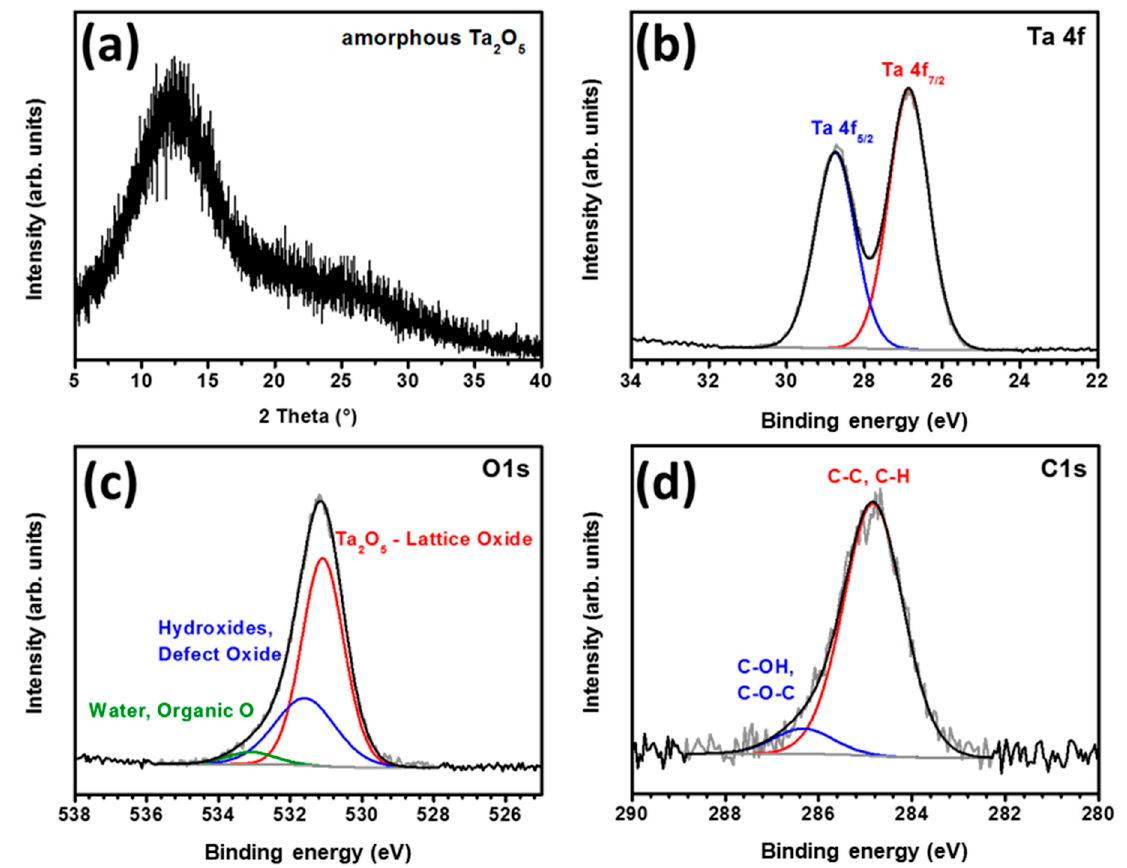
Figure 2. ( a ) XRD pattern of tantalum oxide film deposited on glass; XPS spectra of tantalum oxide showing high-resolution peaks corresponding to ( b ) Ta 4f, ( c ) O 1s and ( d ) C 1s. The electronic states and compositions of the tantalum oxide films were determined using X-ray photoelectron spectroscopy (XPS). The XPS survey spectrum is shown in Figure S4. As seen in Figure 2b, two peaks observed at 28.7 and 26.8 eV were assignable to 4f 5/2 and 4f 7/2 , respectively, corresponding to the Ta +5 oxidation state, which confirmed the formation of stoichiometric Ta 2 O 5 after annealing of the film, since the Ta +5 component was the only phase detected in Ta 4f region [49]. The O 1s region (Figure 2c) exhibited the main peak at 531.1 eV attributed to the lattice oxide, confirming the presence of an O 2 − state in Ta 2 O 5 . The higher binding energy peak centered in the region 531.6–533.1 eV can be assigned to chemisorbed oxygen, defect oxygen atoms or hydroxyl groups and possibly to surface-adsorbed water molecules or organic oxygen (residual ethoxide groups) [49]. The peaks in the C1s spectrum at 284.8 and 286.4 eV in Figure 2d correspond to C–C, C–H